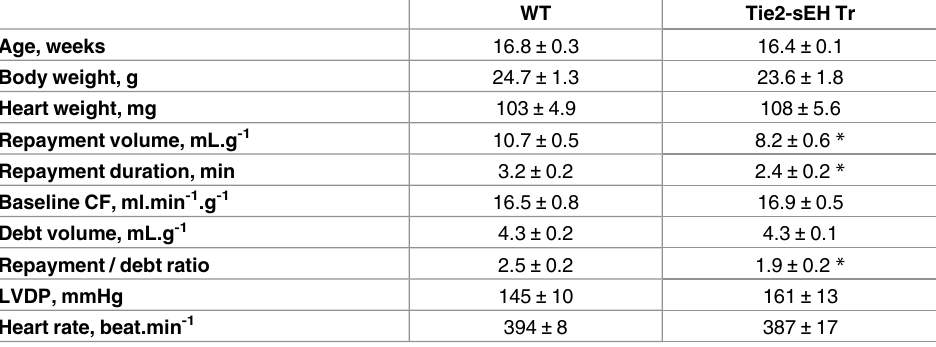
Table 1. Baseline functional data and coronary reactive hyperemia (CRH) parameters for sEH-over- expressed(Tie2-sEH Tr) and wild type (WT) isolated mouse